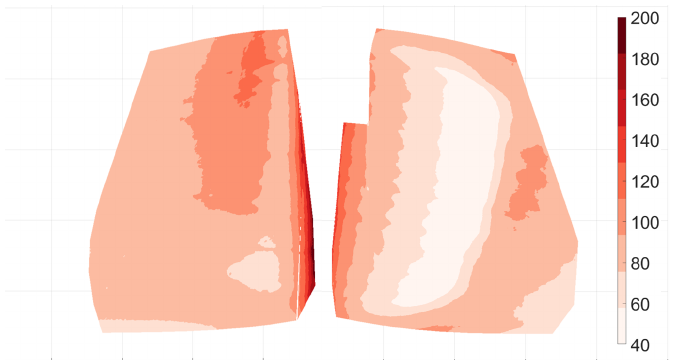
Figure 12. Contours of HTC on pressure ( left ) and suction side ( right ) for flow coefficient φ =